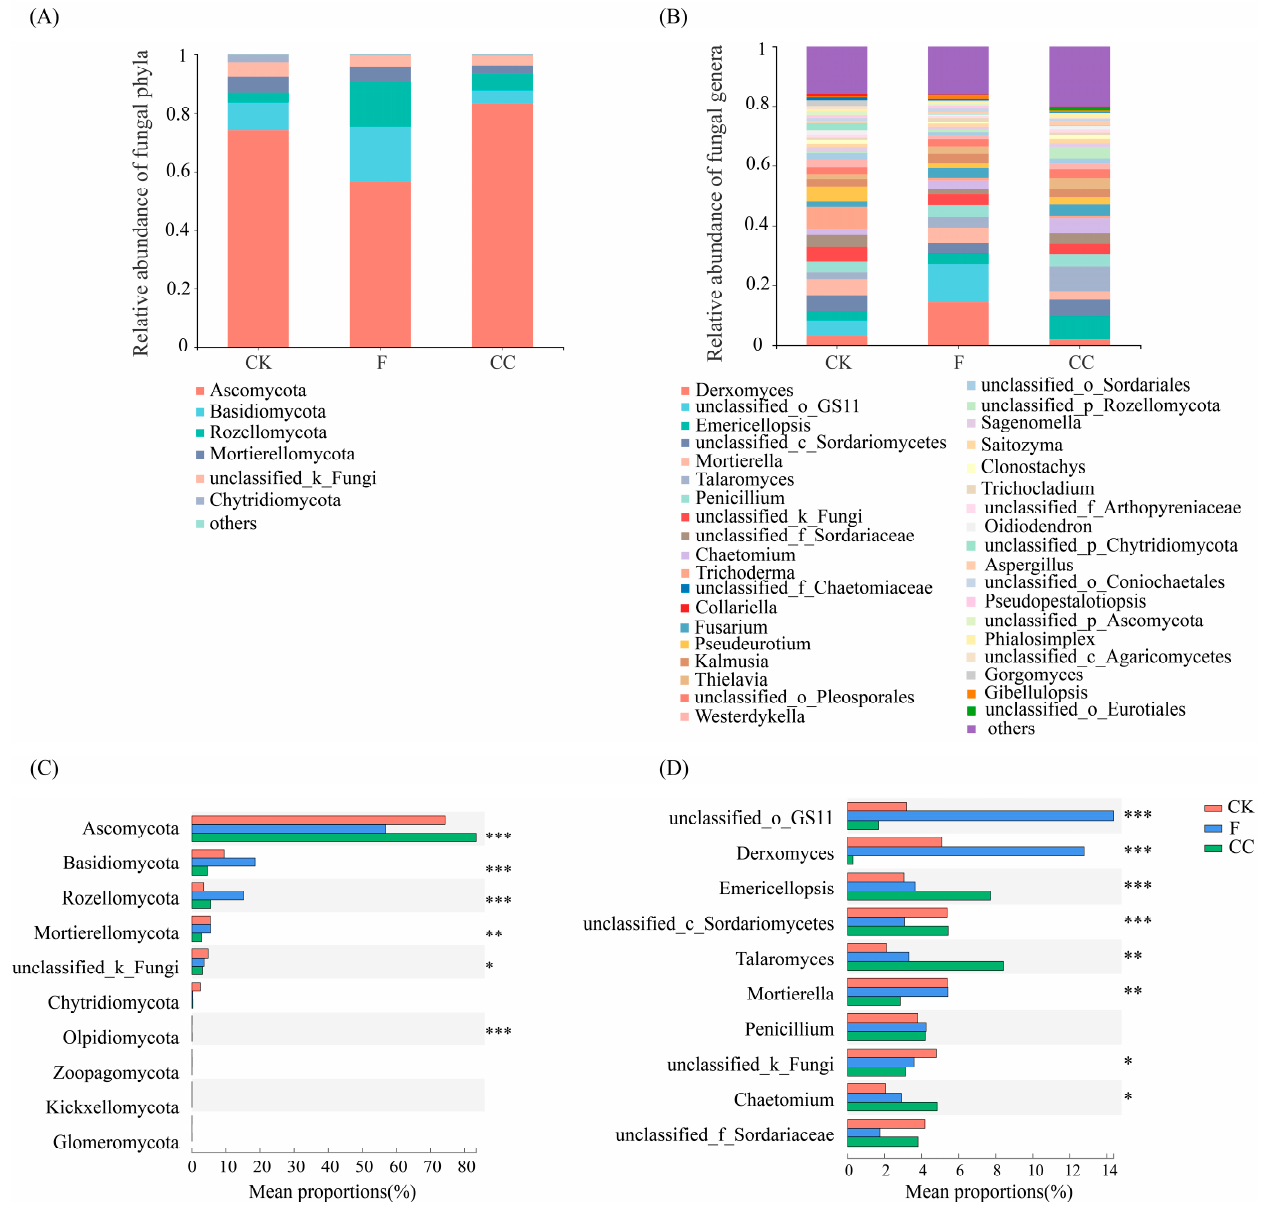
Figure 4. The relative abundance of top fungal phyla ( A ) and genera ( B ), and comparison of top 10 fungal phyla ( C ) and genera ( D ) using One-Way ANOVA analysis in different treatments in tea nursery. The significant differences are denoted by asterisks (* p < 0.05; ** p < 0.01; *** p < 0.001).